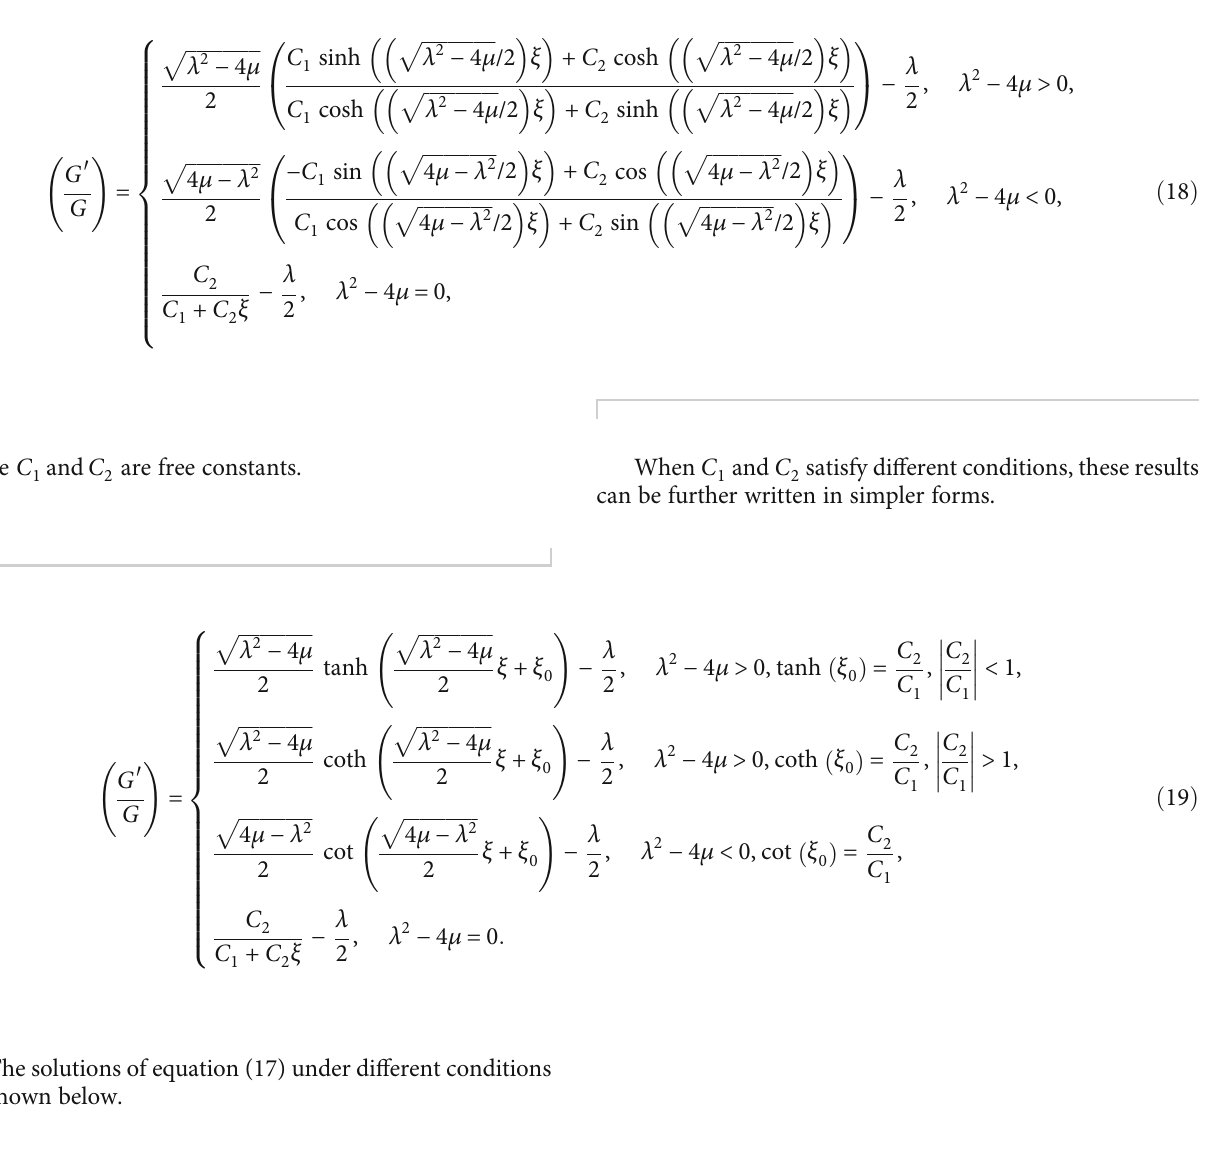
p μ 2 + 4 ω − 4 λω p 4 λω − 4 ω − μ 2